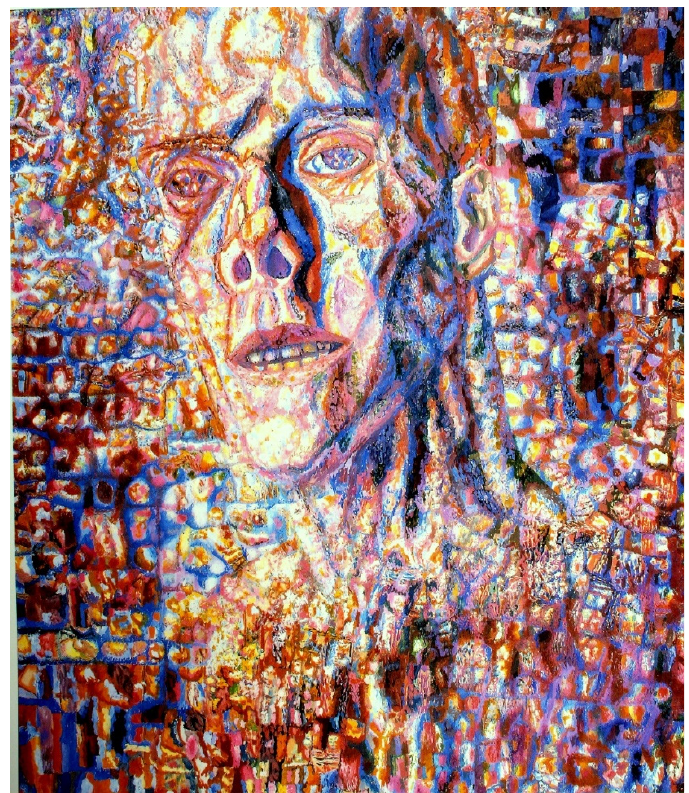
Figure 10. P. Filonov. The Head. III . 1930.